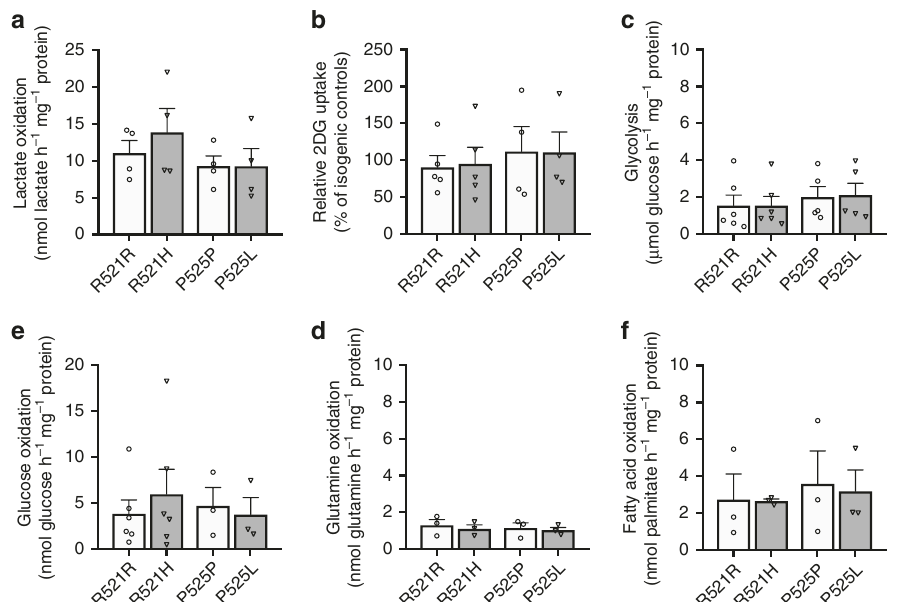
Fig. 6 Mitochondrial and glycolytic fl ux in MNs derived from FUS – ALS patients and isogenic controls. a Lactate oxidation in patient (R521H or P525L) and isogenic control (R521R or P525P) motor neurons. b Glucose uptake in patient and isogenic control motor neurons. c Glycolytic fl ux in patient and isogenic control motor neurons. d Glucose oxidation in patient and isogenic control motor neurons. e Glutamine oxidation in patient and isogenic control motor neurons. f Fatty acid oxidation in patient and isogenic control motor neurons. The data represent mean ± s.e.m. from at least three independent experiments, with individual data points shown. Statistical analyses were performed by one-way ANOVA with post hoc two-tailed t tests between cell lines ( p > 0.05). Dark grey bars indicate FUS-patient cell lines. Light grey bars indicate isogenic controls from these patients. Source data are provided as a source data fi le. 2DG